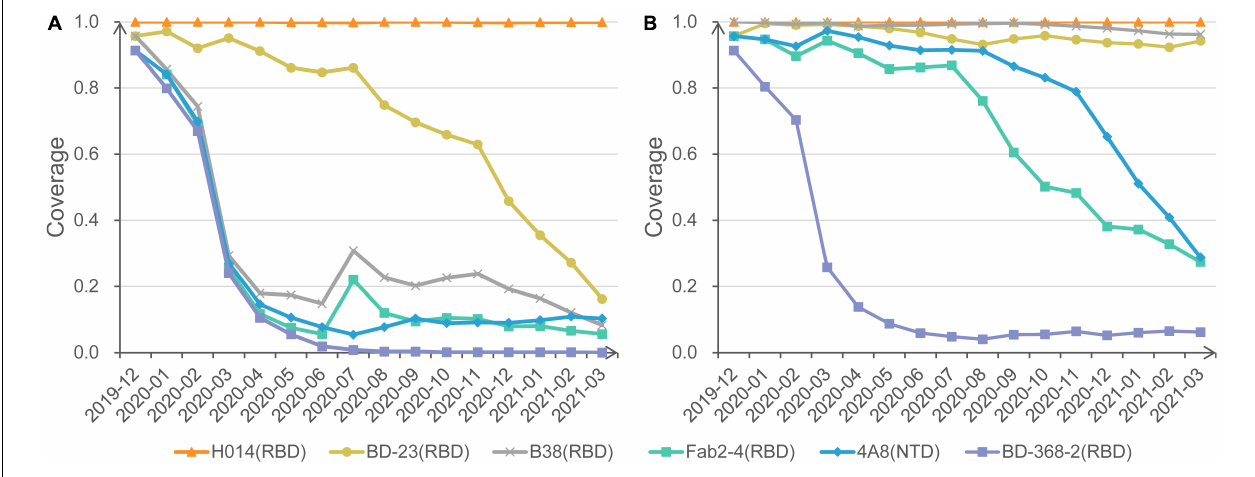
FIGURE 3 | Protection coverage of exemplary anti-S mAbs at different cutoffs. (A) Monthly protection coverage of six mAbs with the cutoff of 0.8. (B) Monthly protection coverage of six mAbs with the cutoff of